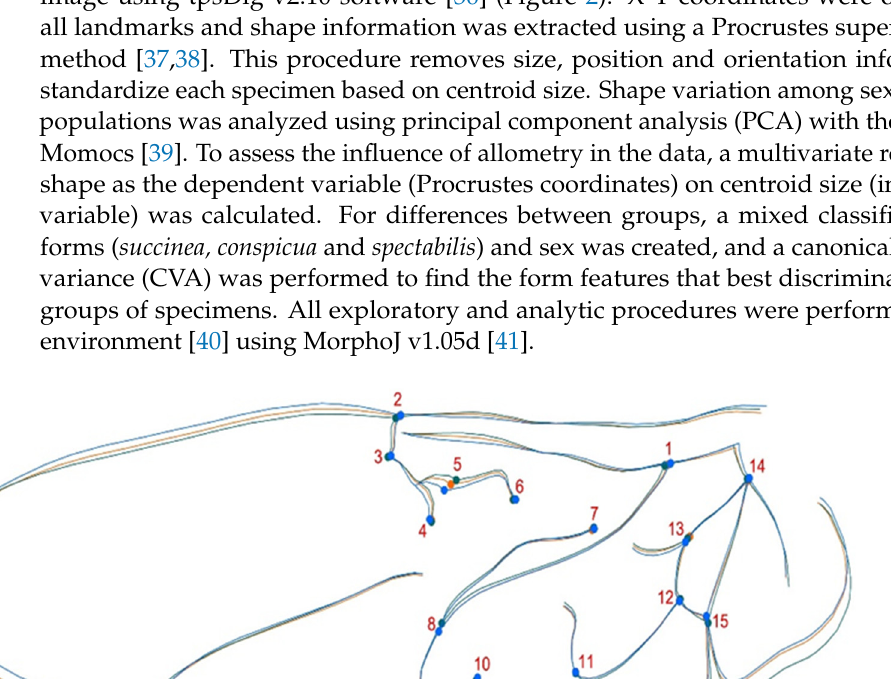
Figure 3. Scatterplot of the principal component analysis of H. axyridis with the corresponding extreme wing shapes of every axis: x-axis=number of dimensions, y-axis=amount of shape variation. Scale represents first two dimensions. The colors represent the different invasive forms: green, conspicua (co); orange, spectabilis (sp); blue, succinea (su).